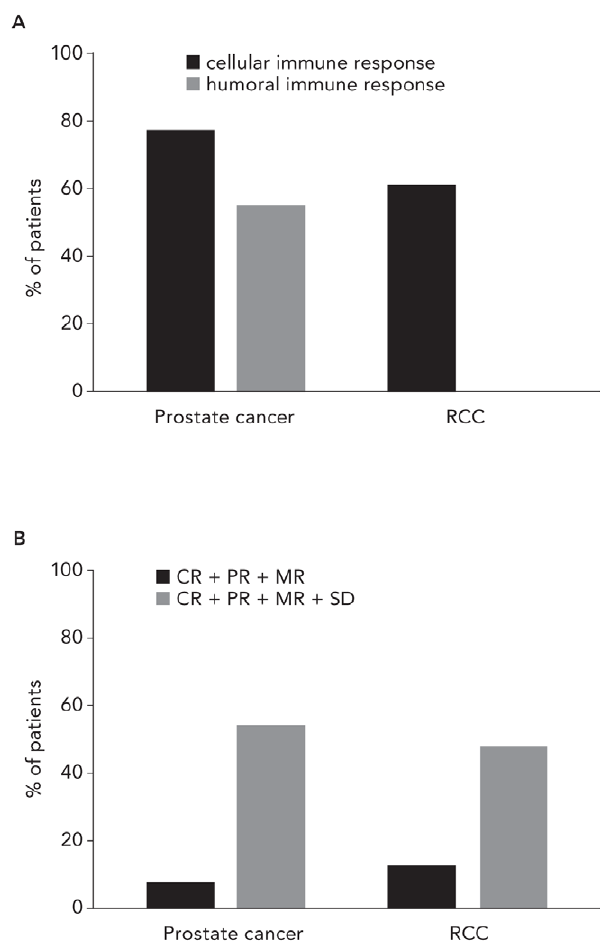
Figure 2. Immune and clinical responses in prostate and renal cell cancer (RCC) patients. (A) Induction of tumor antigen specific cellular or humoral immune responses. An immune response was considered positive when at least one of the conducted assays was positive. (B) Analysis of objective response (black columns) and clinical benefit rate (CBR; grey columns). CR, complete response; PR, partial response; MR, mixed response; SD, stable disease.